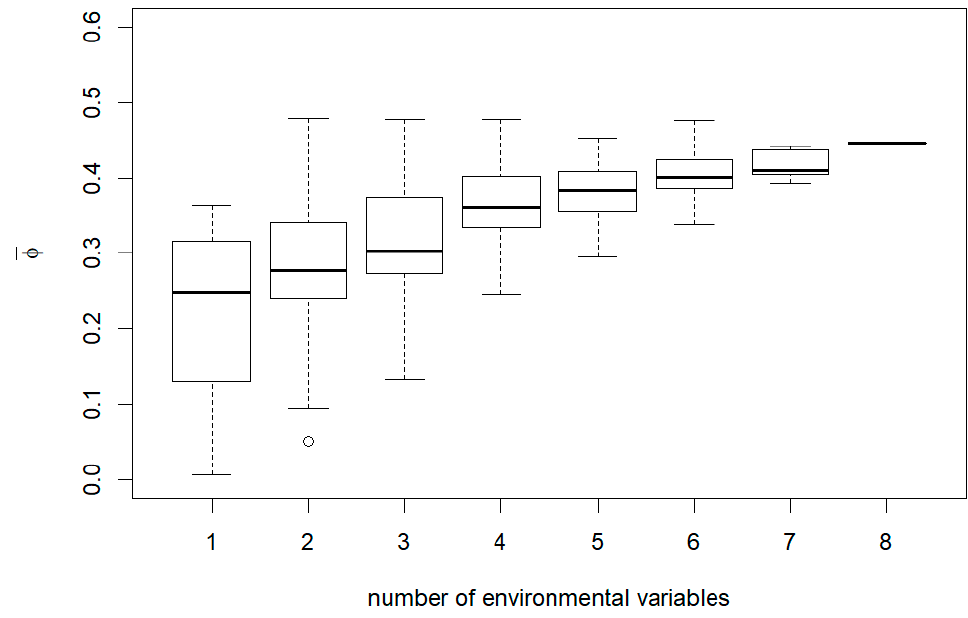
Figure A4. Box plot of mean phi coefficients ( φ ) of the FDMs generated by DTC as affected by the number of explanatory variables. Box plot shows median plus upper and lower quartiles for φ of FDMs with a given number of explanatory variables. Minimum and maximum values are indicated by the upper and lower whiskers (1.5 × interquartile range). Circles are outliers.